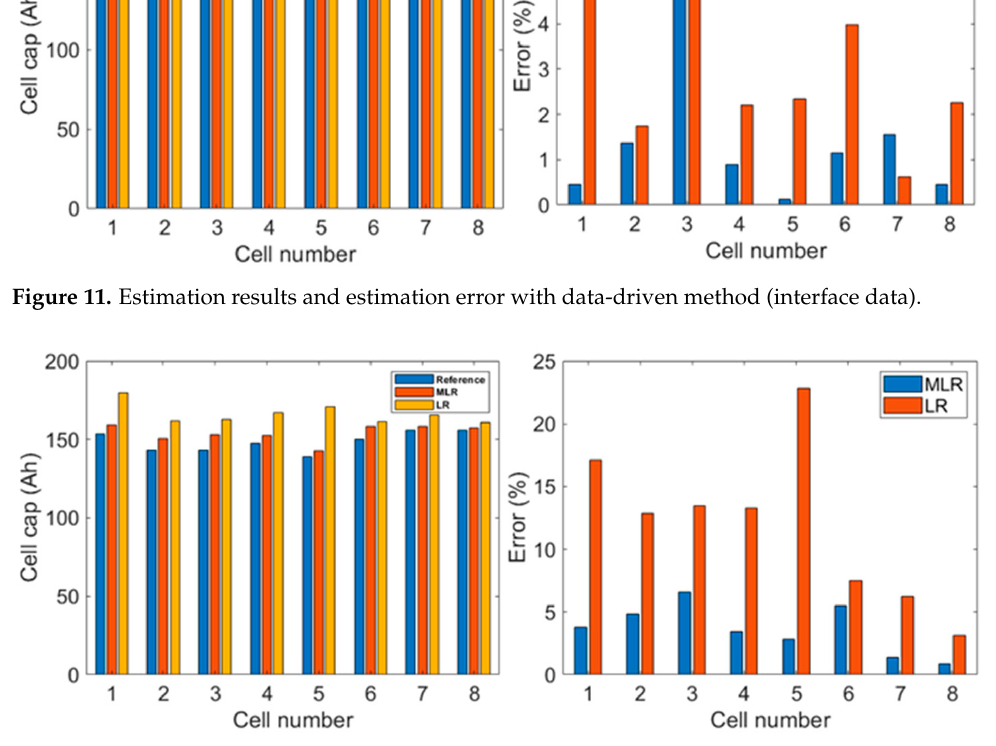
Figure 12. Estimation results and estimation error with data-driven method (aged data). For the curve-matching-based method, we select the #5 cell in the battery pack as the reference battery, and the reference charge curve is extracted. Because the cell charge curve is incomplete, we extract the common cell voltage range, which is about 3.25 to 3.4 V. Then, the platform area expansion coefficient is obtained. The estimated results and the relative error based on interface data are shown in Figure 13. The estimation results show that the method has a general fitness for the battery capacity estimation in this module. The average error is within 2.5%. However, the maximum relative error is up to 11%. In order to find the error source, we get the warping path (Figure 14) and the IC curve (Figure 15). We find that the warping path is more winding and the IC curve is p artly mis- matched. It says that the battery curve deformation is obvious. Furthermore, the IC peak posi- tion moves to the high-voltage side and the repaid-polarization area is much bigger than the other cell. These two factors are the main error sources because we regard the repaid- polarization area as an approximately invariant value. The estimated results and the rel- ative error based on aged data are shown in Figure 16. The estimation error is also larger than the result before the aged data. The average error is 4.19%. This result indicates that the inconsistency of battery curve shape is more and more obvious with the degradation of retired batteries. The difference based on aging characteristics tended to be wider. Figure 13. Estimation results and estimation error with curve-matching method (interface data).